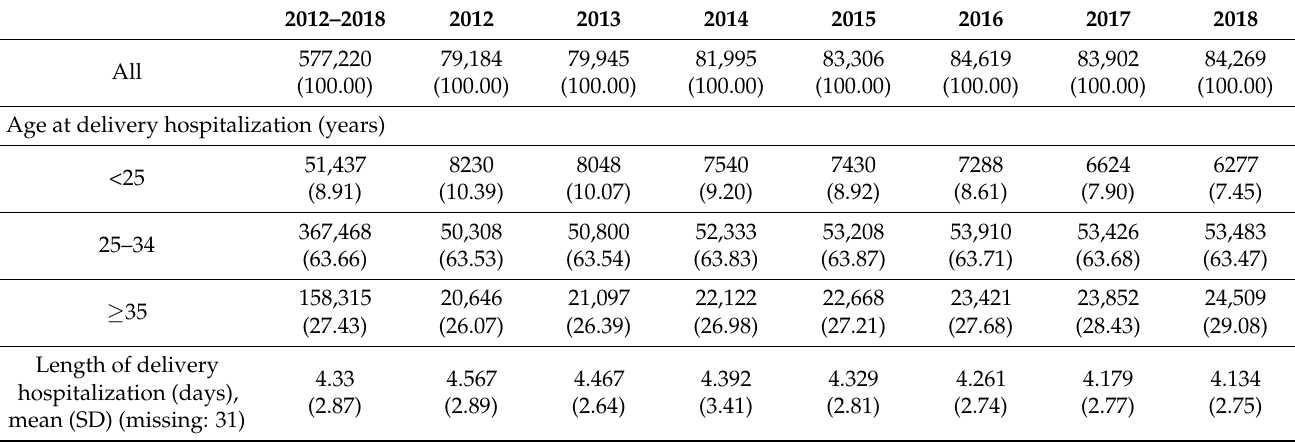
Table 1. Demographics and characteristics of the study population. All variables by maternal age category are shown in Table S3.